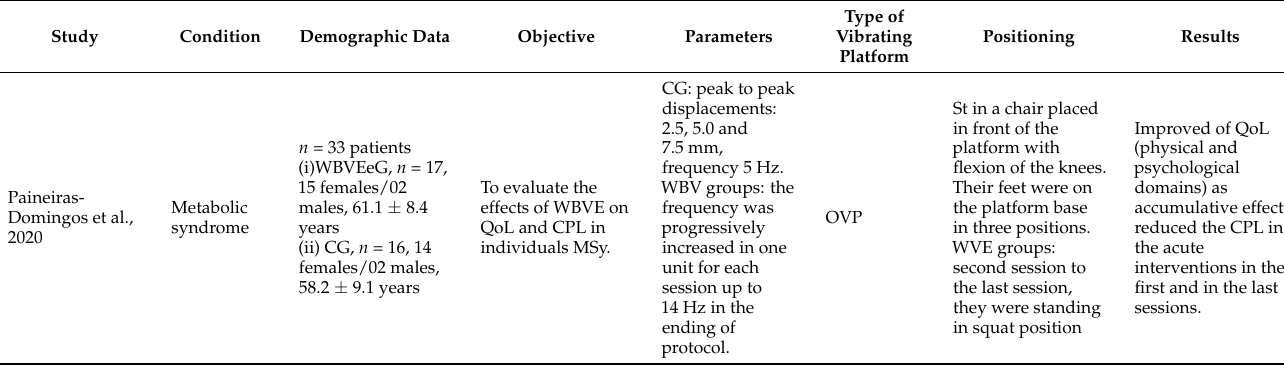
Table 5. Different populations submitted to WBV exercise, with symptoms also observed in the COVID-19 patients: quaity of